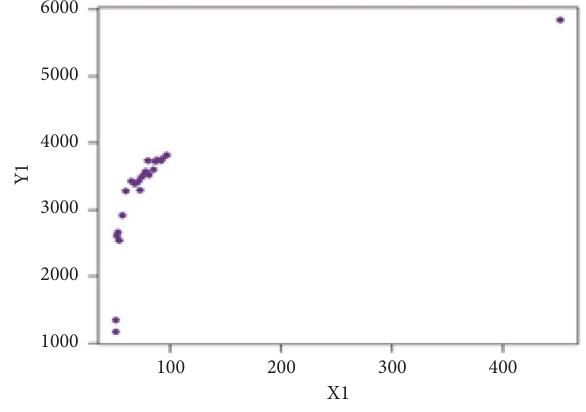
Figure 1: Stratum-I (population-1).